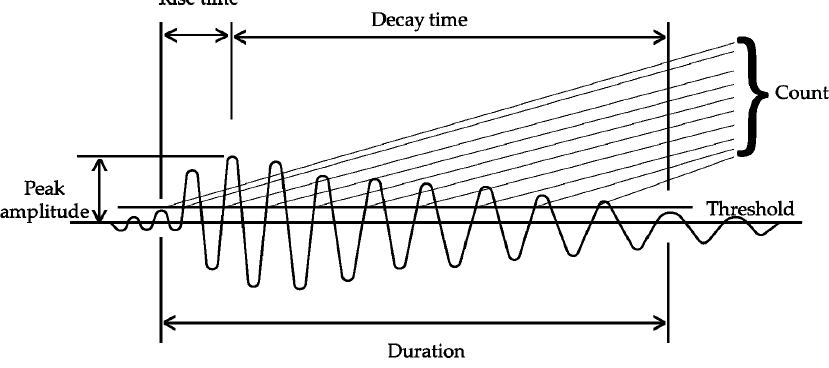
Figure 1. Definition of the acoustic emission (AE) features.